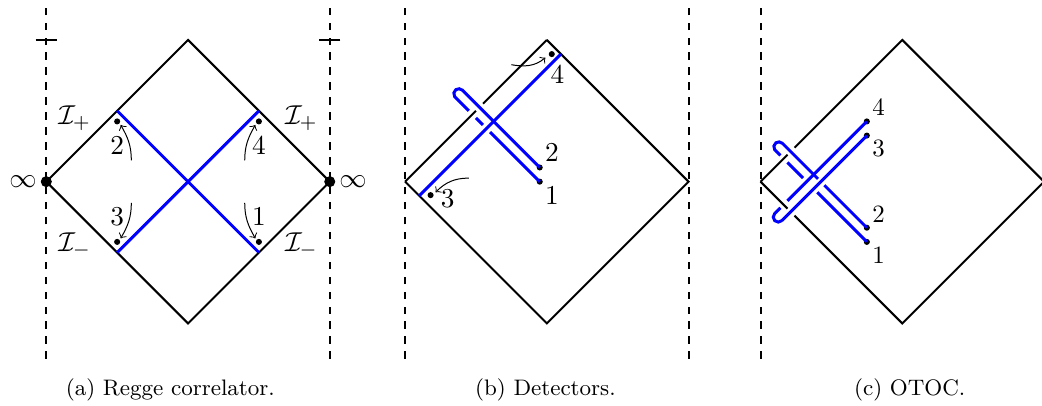
Figure 4 . Geometric interpretation of the equivalence between three CFT correlators in the vacuum. The diamond is a Poincaré patch. For ease of drawing, we display the Lorentzian cylinder in 1+1 spacetime dimension, with vertical dashed lines identified. (More generally, the left- and right- halves of each pictures should be identified, with an S d − 2 sitting atop each point.) (a) In the Regge limit, highly boosted operators approach null infinity and create the thick blue shockwaves. (b) A shockwave at null infinity is an asymptotic measurement or “detector”. The picture is obtained from the first by translating northwest by a bit more than half a Poincaré patch, then folding. (c) The out-of-time correlator is obtained by further translating the detector southwest by half a Poincaré patch, and folding again. Layers follow the Schwinger-Keldysh folds in (3.3) from bottom to